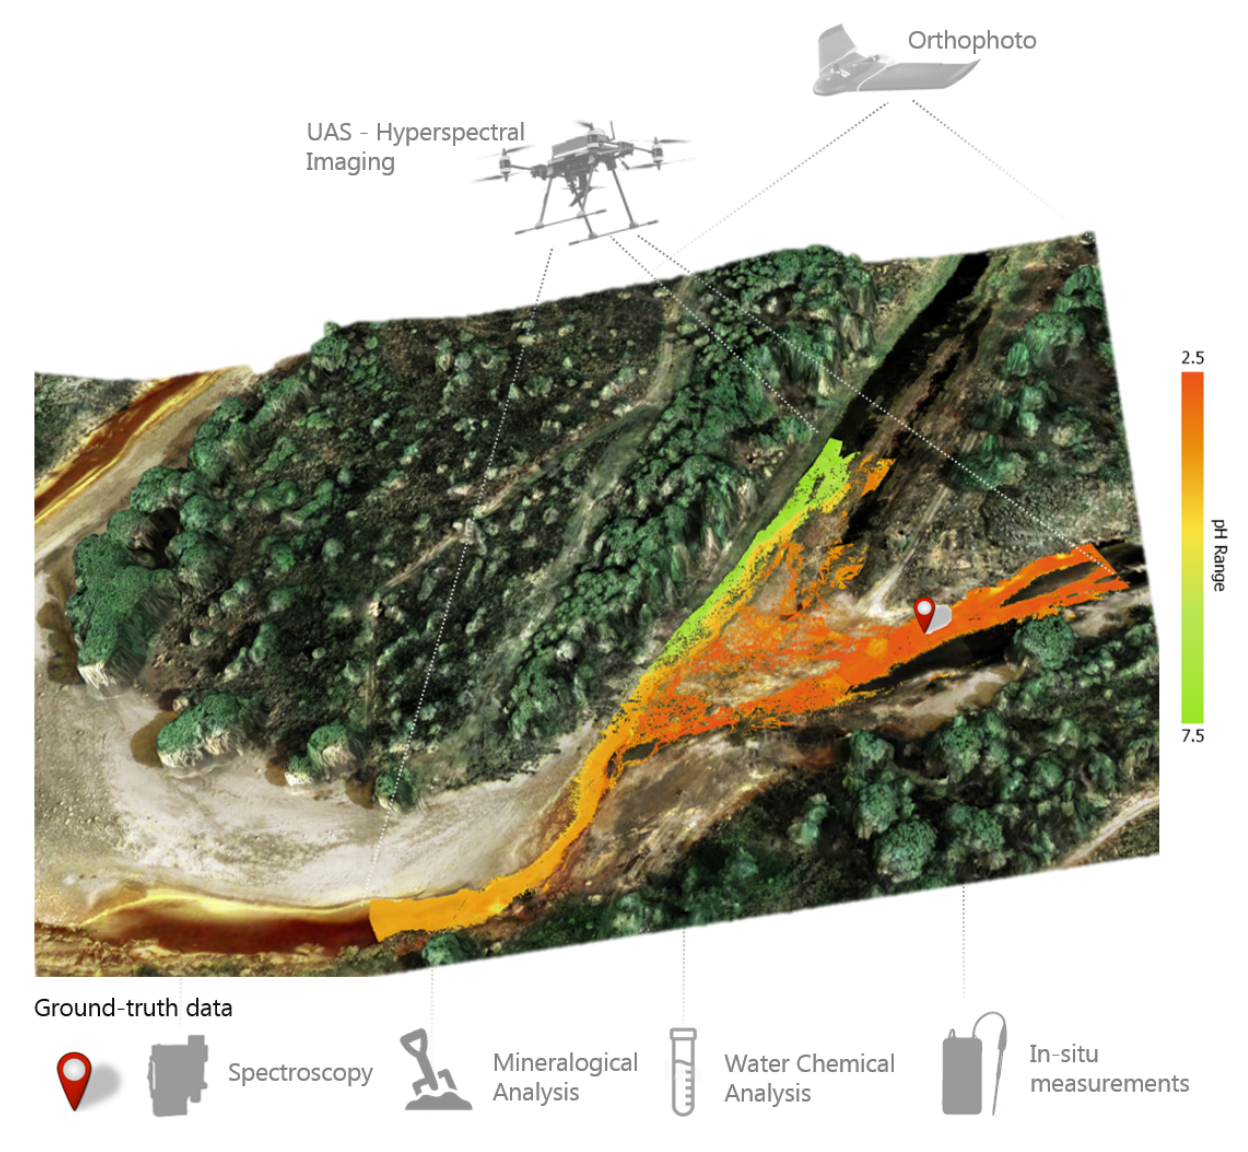
Figure 13. 2.5D surface model representation of the Tintillo–Odiel area. Base layer are the combination of the orthopoto on top of the Digital Surface Model (DSM) and the produced regression–pH map for the river flow path. UAS and further field geochemical techniques used are shown (not drawn to